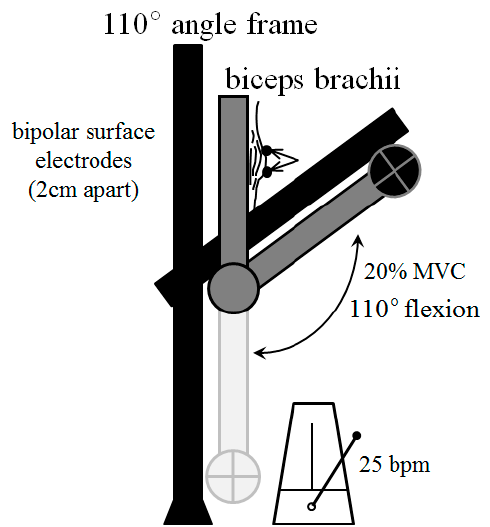
Figure 3. A schematic diagram of the isotonic contraction of the biceps brachii muscles.